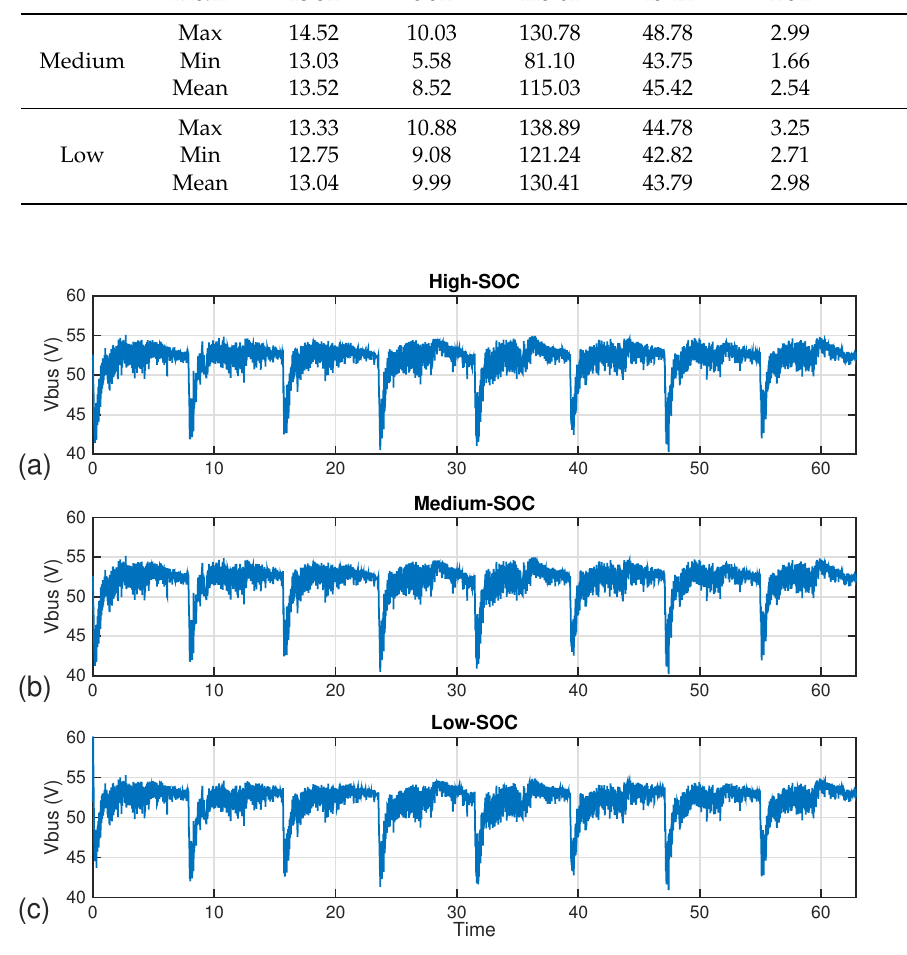
Figure 28. Evolution of the voltage of the DC bus in ( a ) high, ( b ) medium, and ( c ) low SOC full-active hybrid